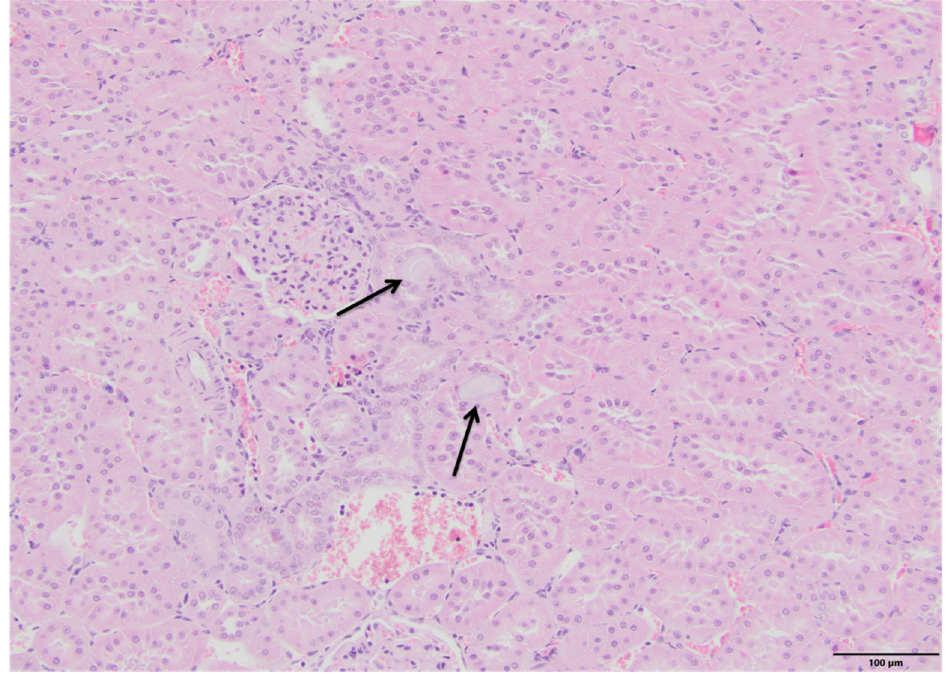
Figure 3. Pathological lesions in kidneys of rats on 60% fructose diet (F10). Two pale basophilic deposits with delicate ring ‐ like substructure within interstitium (arrows). The deposits are non ‐ polarizable, compressed the tubular structures. (HE, magnification 20×).